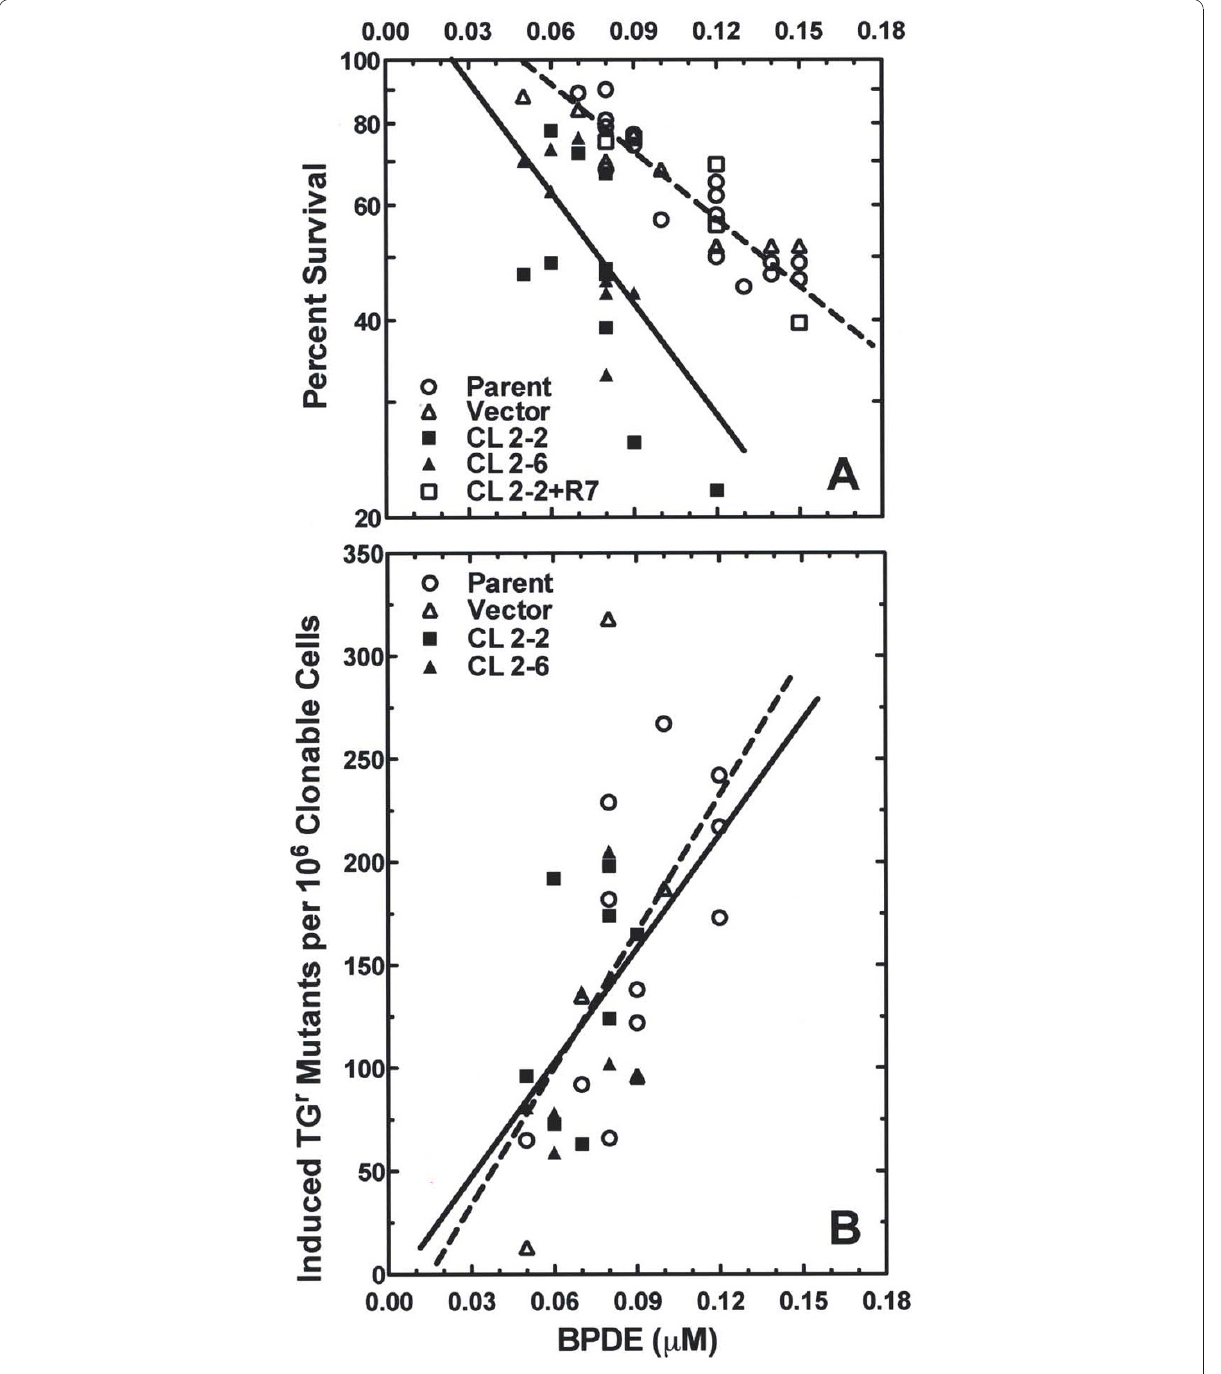
Figure 2 Reducing the level of hRev7 in human fibroblasts renders them more sensitive to the cytotoxic effect of BPDE, but does not affect their frequency of BPDE-induced mutations . The parental cells strain (open circles); cell strains with reduced hRev7, designated clones 2-2 and 2-6 (closed symbols); the vector control strain (open triangles); and a cell strain in which to level of hRev7 was reconstituted, designated 2-2 + R7 (open squares); were treated with BPDE and assayed for (A) cell survival or (B) the frequency of mutations induced in the HPRT gene. The lines represent the least squares regression for the